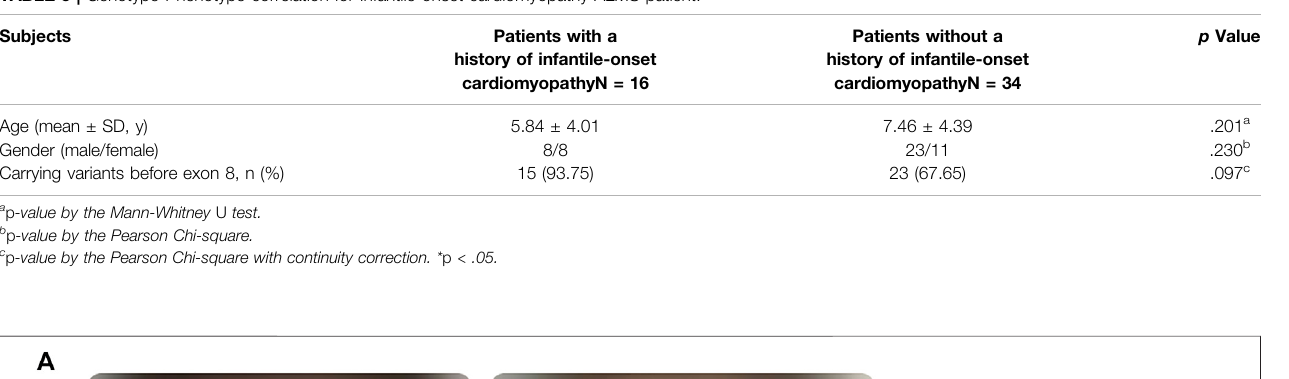
Frontiers in Genetics |